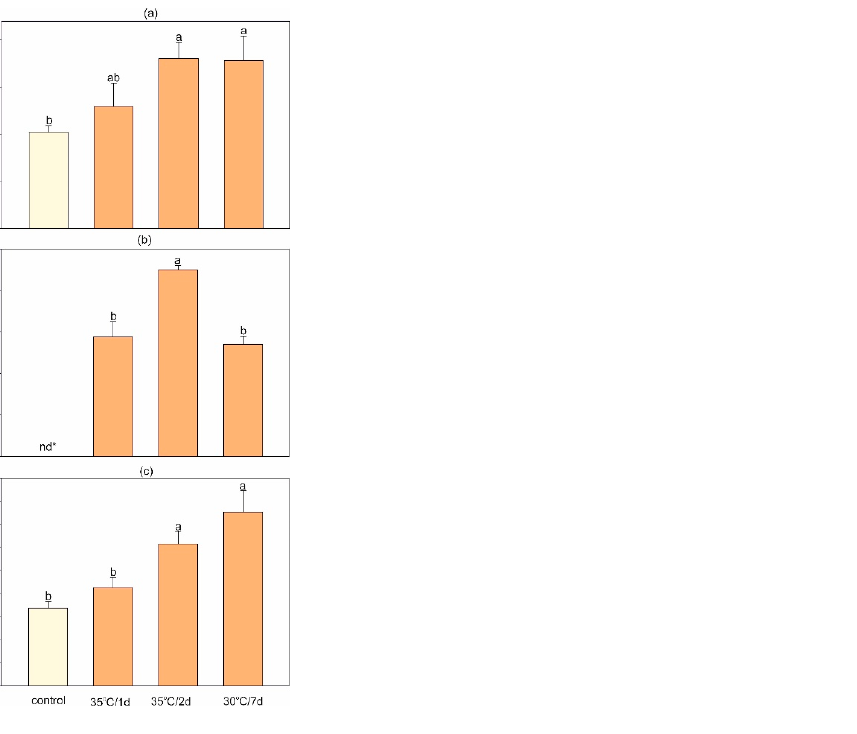
Figure 4. Changes in furanocoumarin contents: ( a ) xanthotoxin, ( b ) isopimpinellin, and ( c ) bergapten in H. sosnovskyi in response to stress temperature. Data are means ± SE ( n = 4), nd*—not detected. Values followed by the same letter(s) are not significantly different according to Tukey’s test ( p < 0.05).